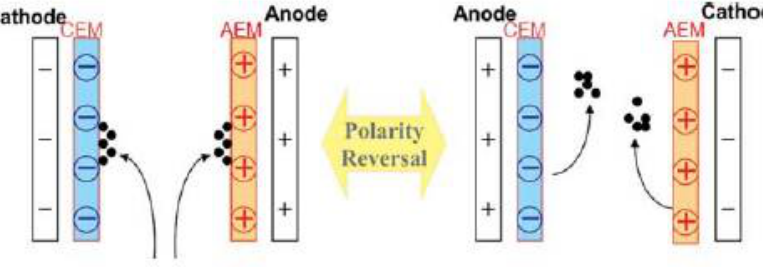
Figure 35. Polarity change in ED processes.